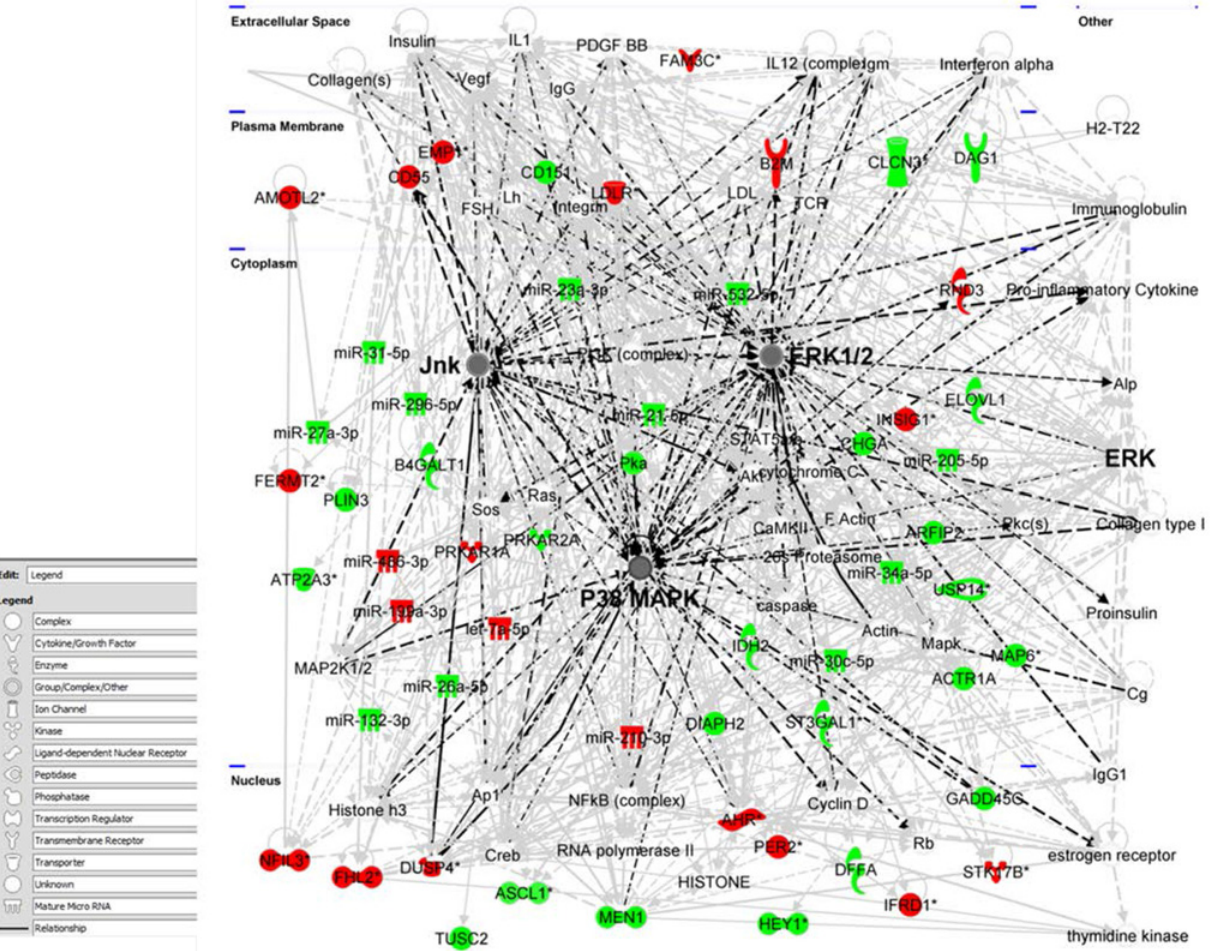
Fig 4. ERK/MAPK Signaling Pathway. IPA was used to generate a network of molecules from mRNA and miRNA that were significantly different in peripheral airway field of cancerization in lung cancer patients compared to smoker controls. This composite network merge three top networks based on “ network score, ” which converges on the ERK/MAPk pathway: specifically merging on Extracellular signal-related kinases 1 and 2 (ERK1/2), c-Jun N-terminal kinases (JNKs), and p38 kinases subfamily. Red is up-regulated and Green is down-regulated.